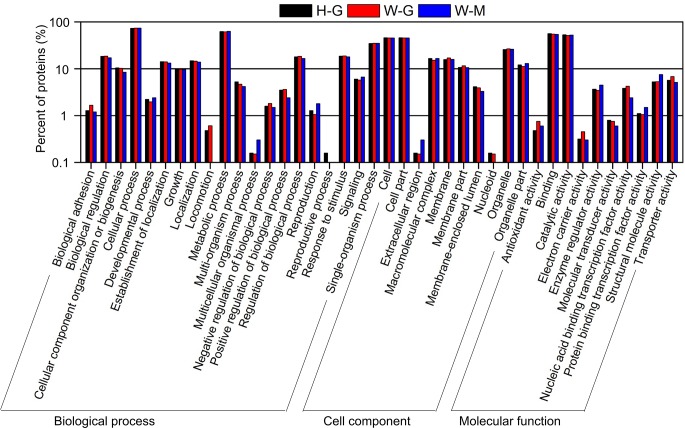
A gene ontology analysis of the phosphoproteins in H-G, W-G and W-M.H-G: glycerol cultured Δhog1 strain; W-G: glycerol cultured WT strain; W-M: methanol cultured WT strain.